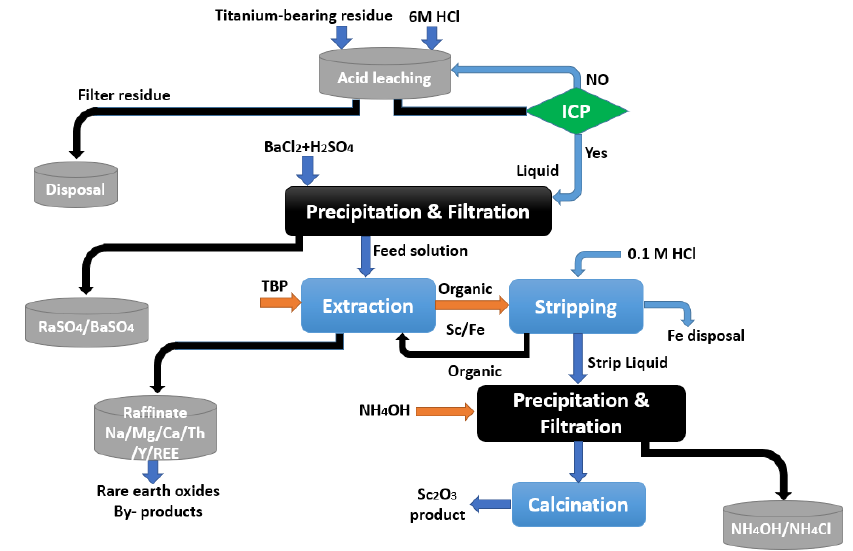
Figure 10. Flow-chart for scandium recovery from titanium-bearing wastes, adapted from [112]. The radium was removed from the leachate solution by adsorption on fresh BaSO 4 after the residue was leached with 6 mol/L HCl. TBP was used to separate scandium from primary elements such as sodium, calcium, and magnesium, as well as minor elements such as thorium, yttrium, and lanthanides in the filtrated solution. The co-extracted iron was left in the organic phase after the scandium stripping by 0.1 mol/L HCl